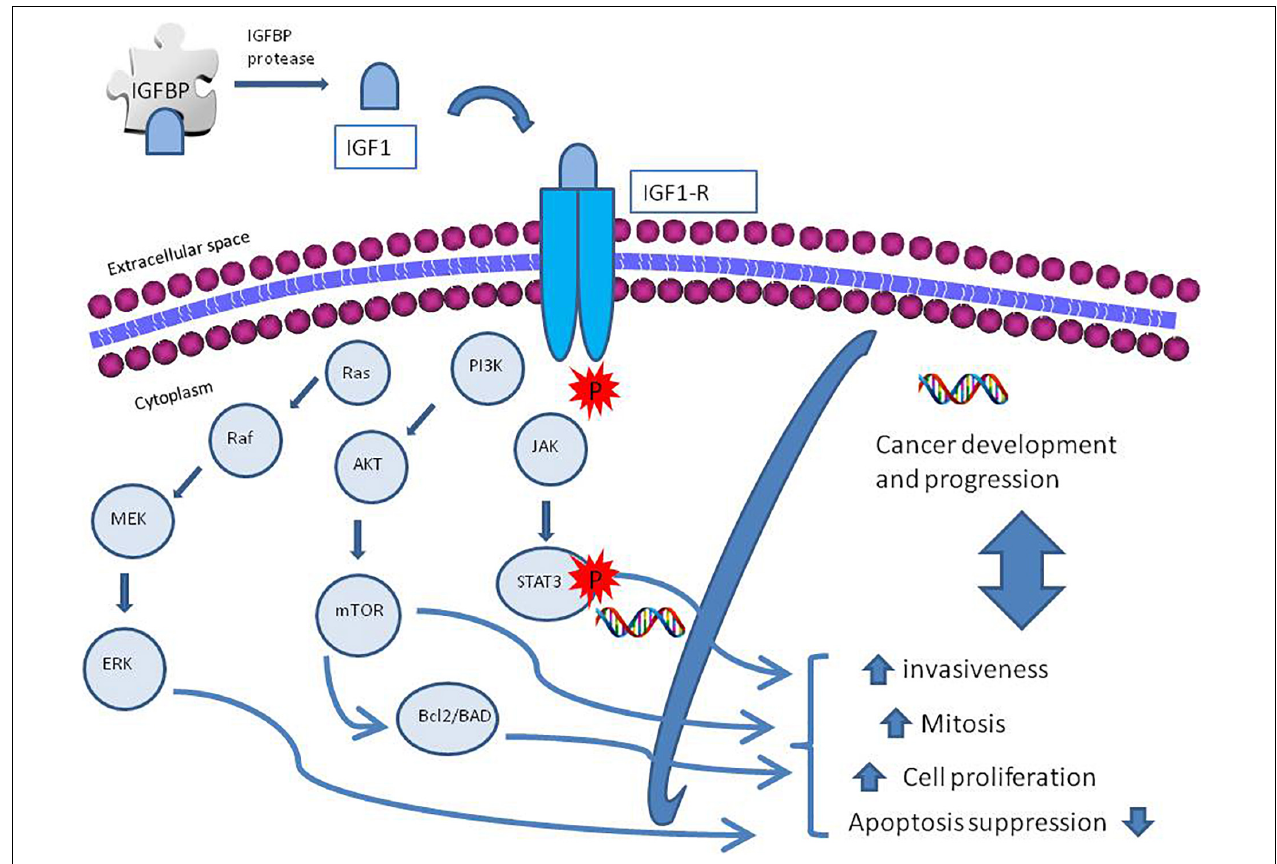
FIGURE 1 | A schematic diagram of insulin growth factor-1 receptor (IGF-IR) activation and regulation. The IGF axis consists of ligands as insulin, insulin-like growth factor 1 and 2 (IGF-1, IGF-2), receptor, IGF binding proteins (IGFBPs) 1–7, and IGFBP proteases. The IGF ligands bind their receptors and binding proteins with high affinity. IGFBPs bind tightly to IGF ligands, influencing binding to their receptors; IGFBP proteases cleave the IGFBPs into fragments with lower affinity for the IGF ligands, thereby increasing free IGF-1 and IGF-2 bioavailability. Activation of IGF-1R promotes cellular growth, proliferation, survival, and metastasis via activation of molecular pathways downstream; among them the phosphatidylinositol 3-kinase (PI3K)-AKT and RAS-extracellular signal-regulated kinase (ERK)